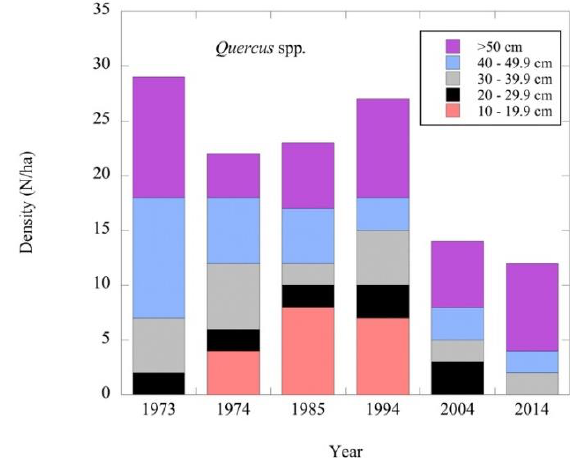
Figure 4. Density (N/ha) distribution by diameter class (DBH ≥ 10.0 cm) of Fraxinus americana individuals recorded at each of the six sampling periods at Dinsmore Woods.